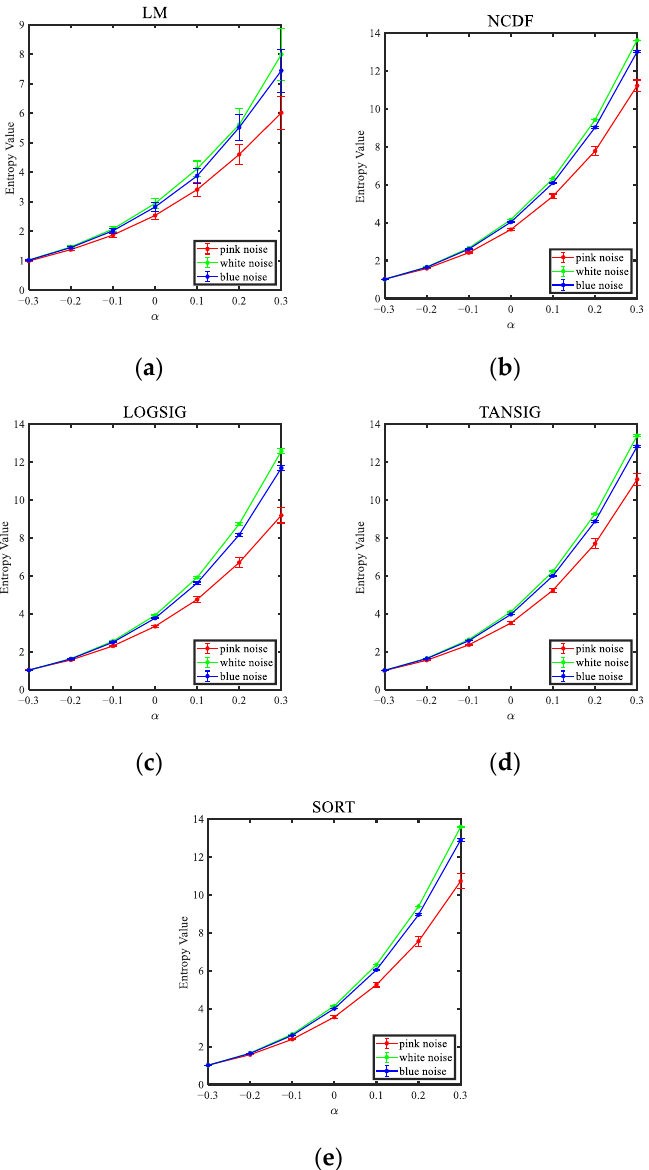
Figure 4. Means and standard deviations of different mapping approaches at different fractional orders. ( a ) LM; ( b ) NCDF; ( c ) LOGISG; ( d ) TANSIG; ( e ) SORT